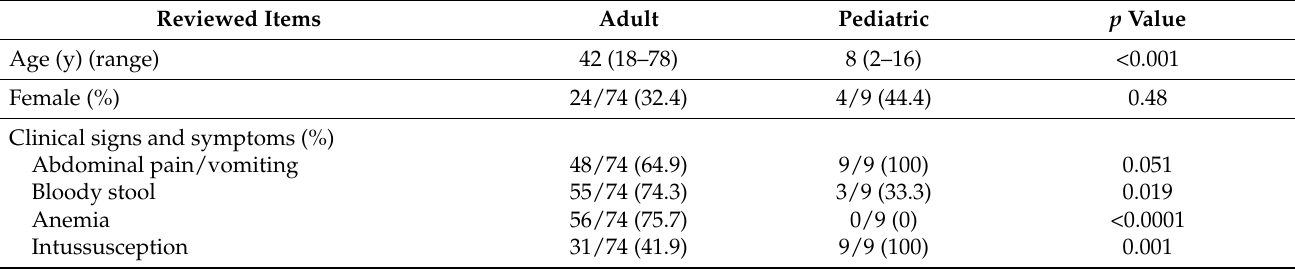
Table 1. Comparison of adult and pediatric cases of inverted Meckel’s diverticulum in the literature